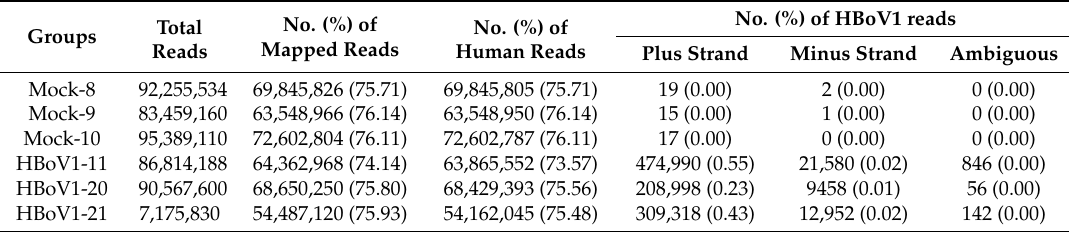
Table 1. Summary of mRNA-seq results.